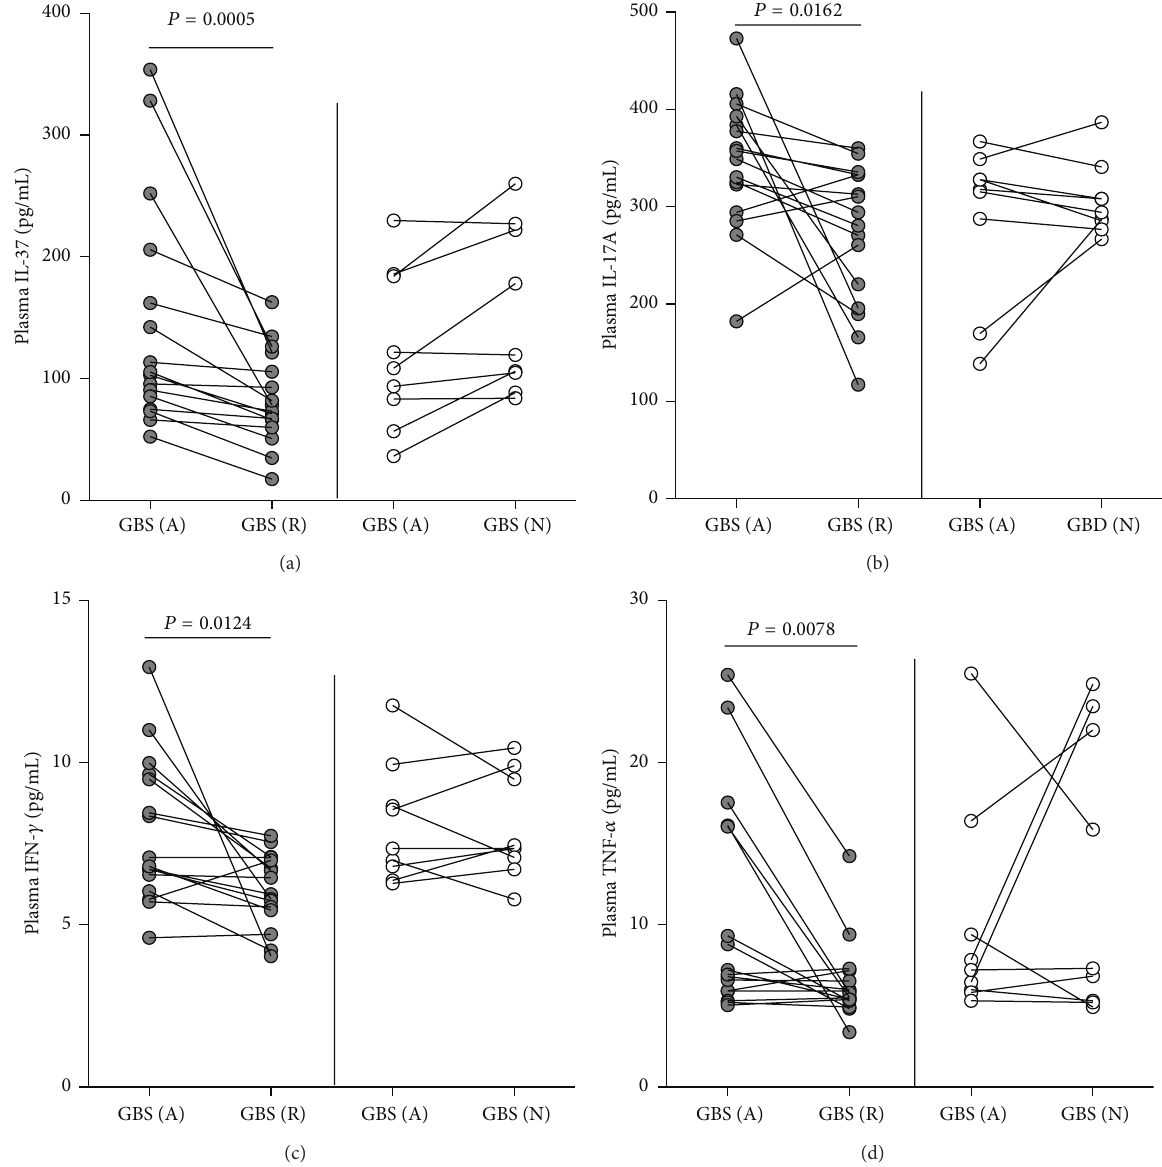
Figure 4: Treatment with IV-Ig significantly reduces the levels of plasma cytokines tested in the drug-responding patients, but not in the drug nonresponders. The concentrations of plasma IL-37 (a), IL-17A (b), IFN- 𝛾 (c), and TNF- 𝛼 (d) were determined at 4 weeks after the treatment and compared with those before the treatment in 16 therapy responders (grey dots) and nine therapy nonresponders (white dots). Data shown are values of individual patients before and after the treatment. GBS (A): patients at acute stage; GBS (R): drug responders; GBS (N): drug